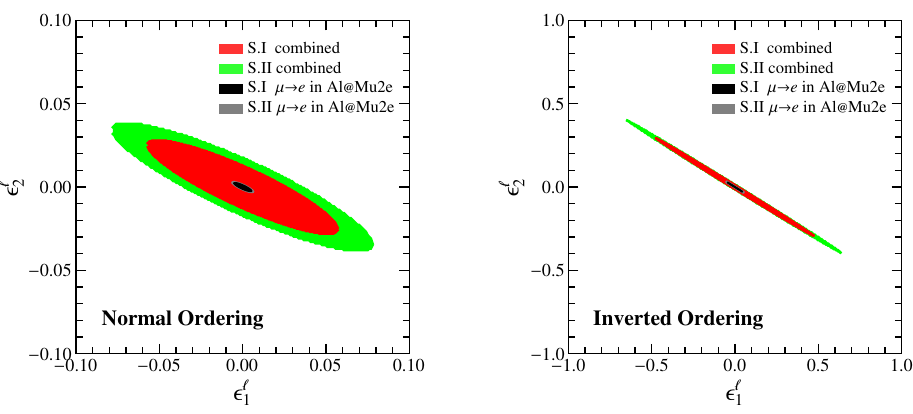
Figure 3 . Combined constraints on ( (cid:15) u the NO (Left) and IO (Right) cases, which are dominated by the (cid:22) ! e(cid:13) decay. The red and green regions are the allowed parameter space in Scenario I and II, respectively. The tiny black and dark regions indicate the future sensitivity to the (cid:22) ! e conversion in Al at the Mu2e experiment.